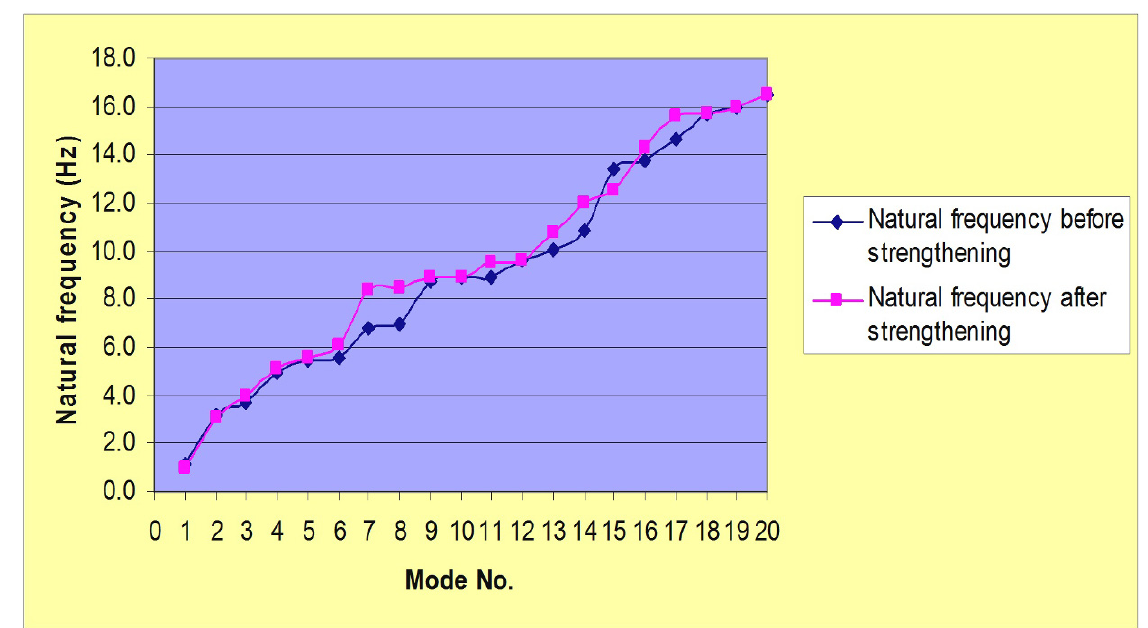
Figure 16. The natural frequency of the bridge structure before and after